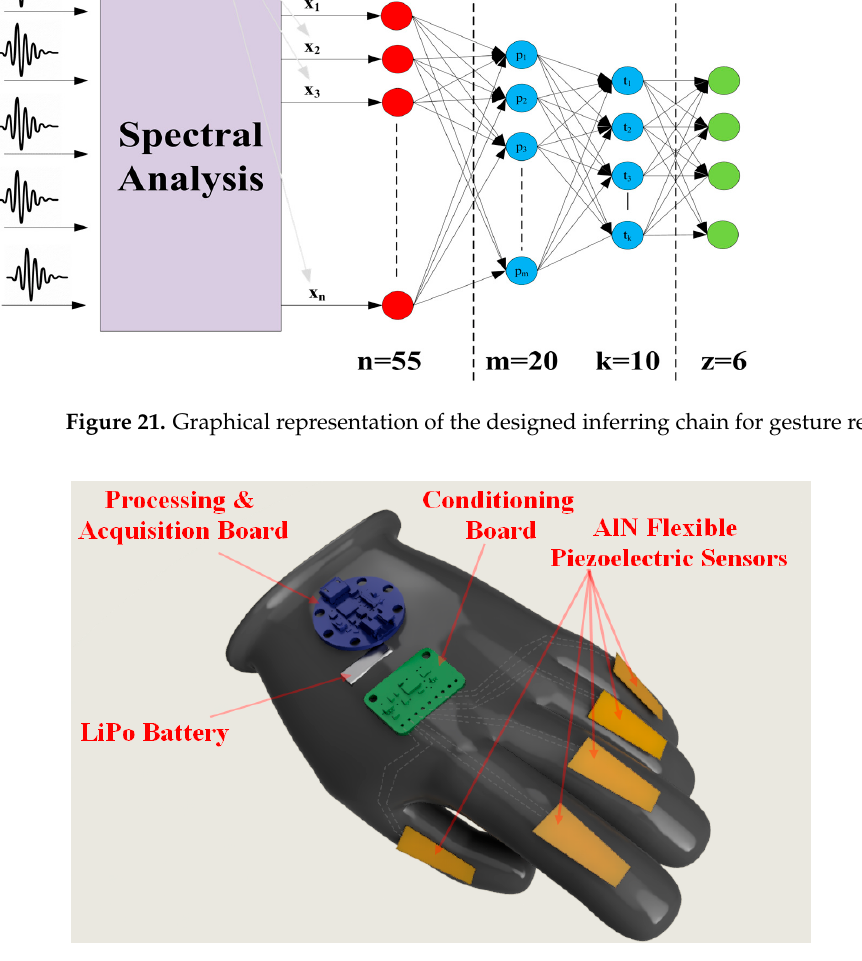
Figure 21. Graphical representation of the designed inferring chain for gesture recognition.